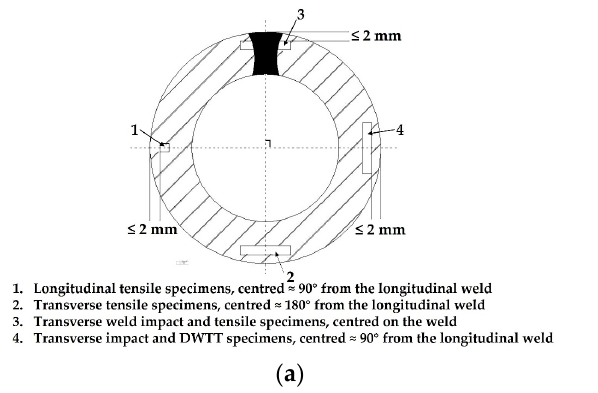
Table 1. Chemical composition of studied steel (mass%).